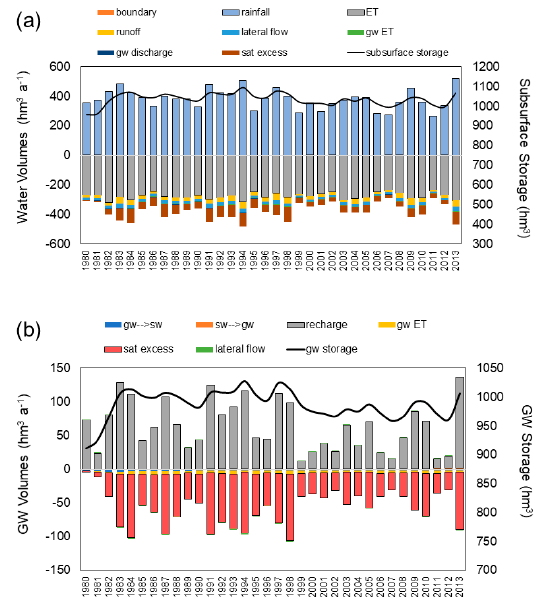
Figure 8. Time series of hydrologic flux volumes for ( a ) the entire watershed and ( b ) the aquifer system, for 1980-2013. For the legends, “gw” refers to groundwater, “ET” refers to evapotranspiration, “sw” refers to surface water, “gw → sw” refers to groundwater discharge to streams, “sw → gw” refers to stream seepage to the aquifer, “sat excess” refers to saturation excess flow, and “boundary” refers to groundwater flow across the watershed boundary.